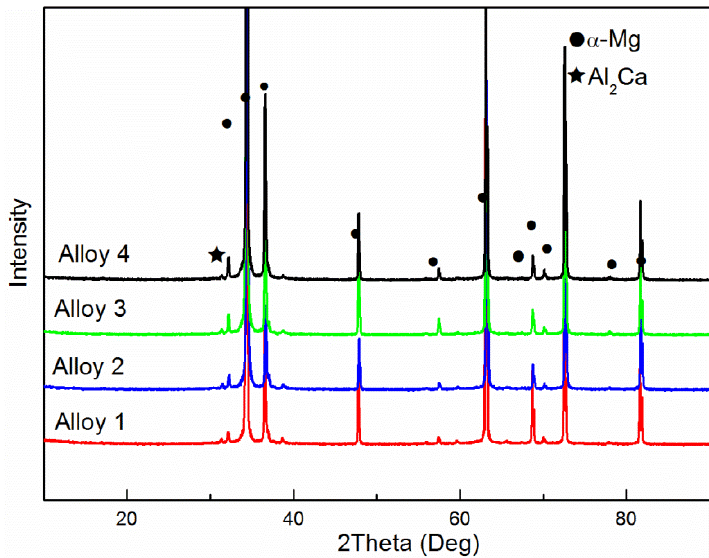
Figure 6. X-ray diffraction spectra of the extruded sheets.